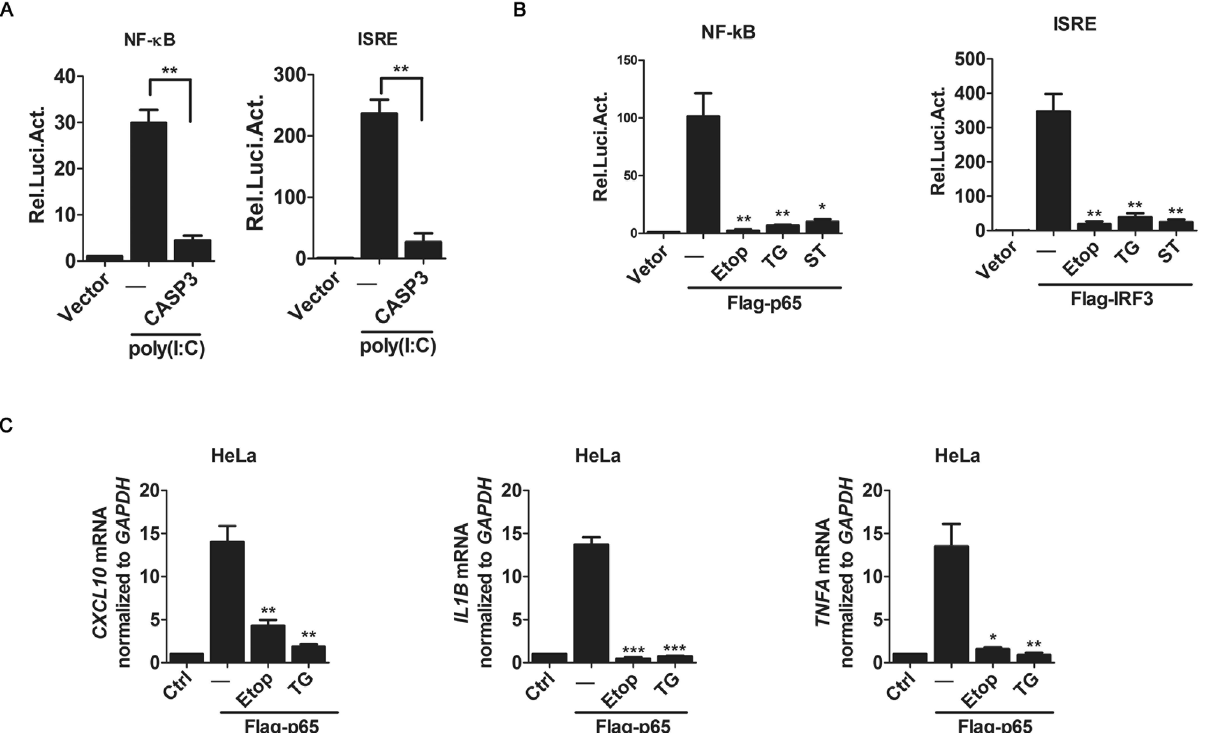
Fig. 3 Caspase-3 downregulates cytokine production induced by p65/RelA. A , B Luciferase assay analyzing NF- κ B and ISRE promoter activity in 293-TRL3 cells transfected for 48 h with the plasmids encoding NF- κ B or ISRE fi re fl y luciferase reporters and TK Renilla luciferase reporter for control, along with transfected the plasmid or treated with poly(I:C) ( A ) and Etop, TG, ST ( B ) as indicated. C qRT-PCR analysis of CXCL10 , IL1B and TNFA mRNA in HeLa cells transfected with the Flag-p65 plasmid and treated with Etop or TG as indicated. Data are representative of three independent experiments (means with SEMs). * p < 0.05, ** p < 0.01, and *** p <